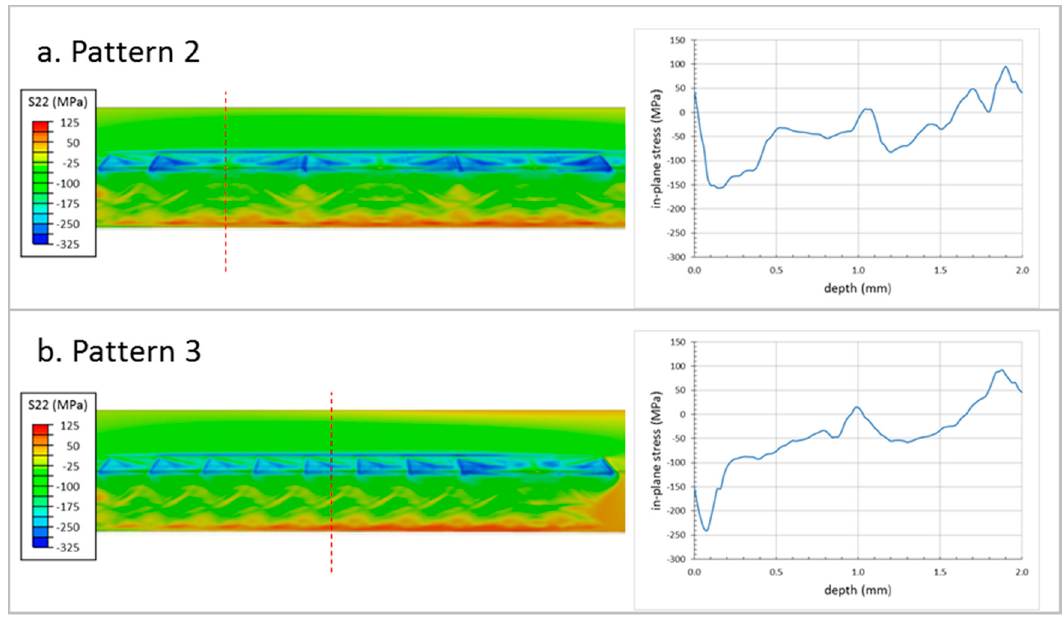
Figure 11. Effects of peen layering on predicted in-plane residual stress: ( a ) Pattern 2; ( b ) Pattern 3. The patterns are shown in Figure 10.